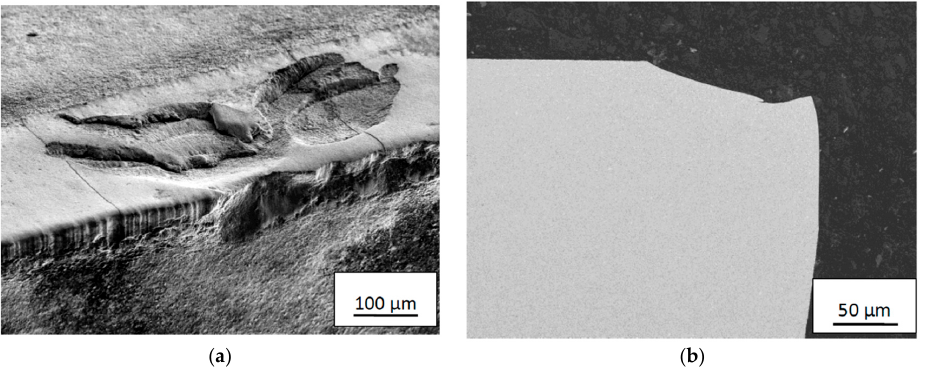
Figure 20. Cracking and macroscopic chipping within the crater ( a ) and fracture of cutting edge region ( b ) obtained at a combination of v c = 115 m/min and f n = 0.2 mm/rev after 1–2 min and above 2 min, respectively.